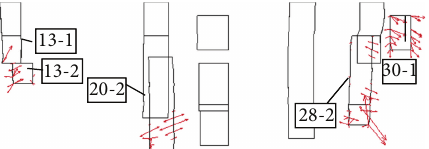
Figure 19: Local distribution of cracks unbalanced force (scheme 1, under overload 2.0𝑃 0